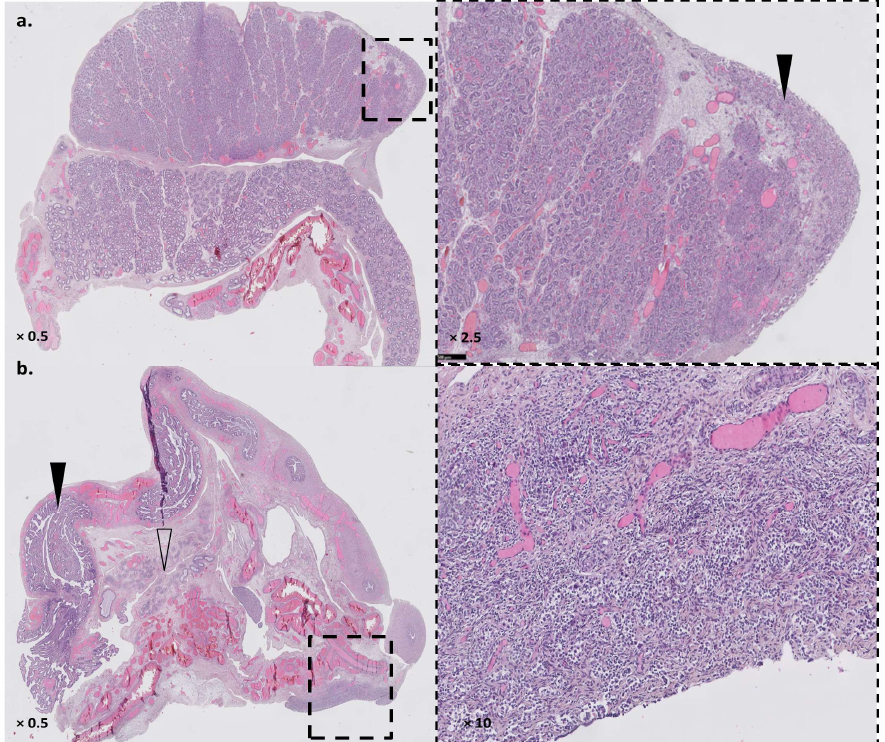
Figure 2. Gonadal phenotype of the fetus. Panel ( a ): right testis-like gonad with small area of undifferentiated tissue (dashed box, black arrowhead). Panel ( b ): left streak gonad (dashed box) with both fallopian tube (black arrowhead) and epididymis (white arrowhead). Magnification shows an undifferentiated ovarian-like tissue with rare primordial germ cells and absent albuginea.